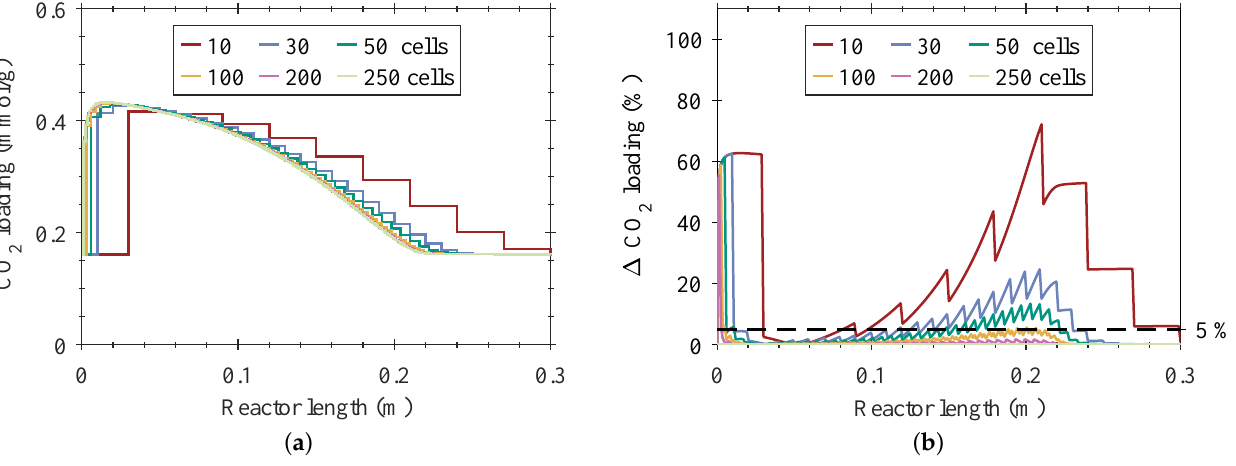
Figure 5. MoL grid analysis with N = 10 to 250 cells for reactive adsorption in one reaction chamber. ( a ) CO 2 loading, and ( b ) deviation of CO 2 loading from N = 250 as a function of the reactor length at t =